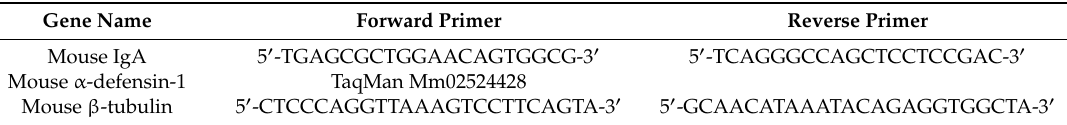
Table 2. Primer sequences used for quantitative